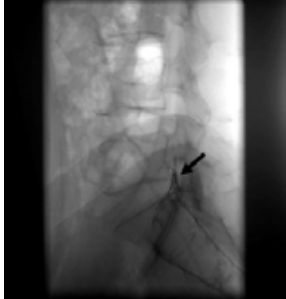
FIGURE 1 - Before lysis of epidural adhesions.